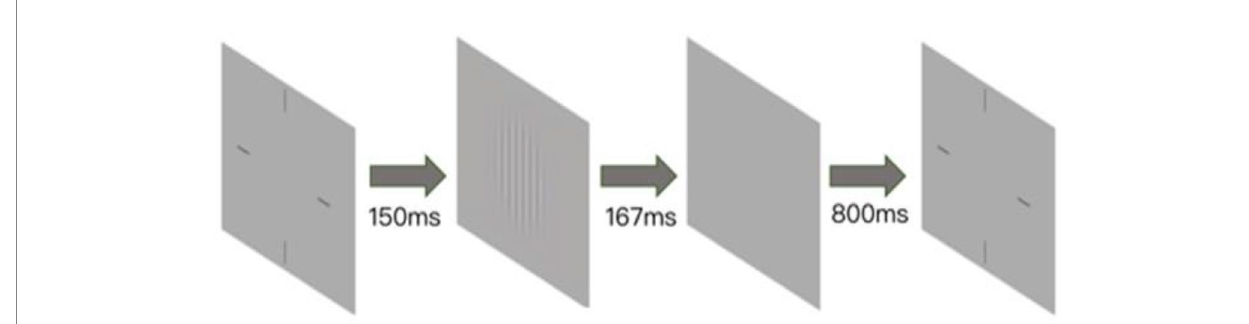
FIGURE 1 Illustration of contrast sensitivity detection with the Zhishiyuan Testing Station. A brief beep indicates the start of a trial, along with the presentation of a crosshair (3.0 × 3.0 ° ) that indicates the location of the stimulus. After 150 ms, the crosshair disappeared, and a stimulus grating of vertical or horizontal orientation (with equal probability) was displayed for 167 ms. A blank background (mean luminance of 74.5 cd/m 2 ) was then displayed, and subjects were instructed to report the orientation of stimuli with the corresponding arrow key. The intertrial interval was 800